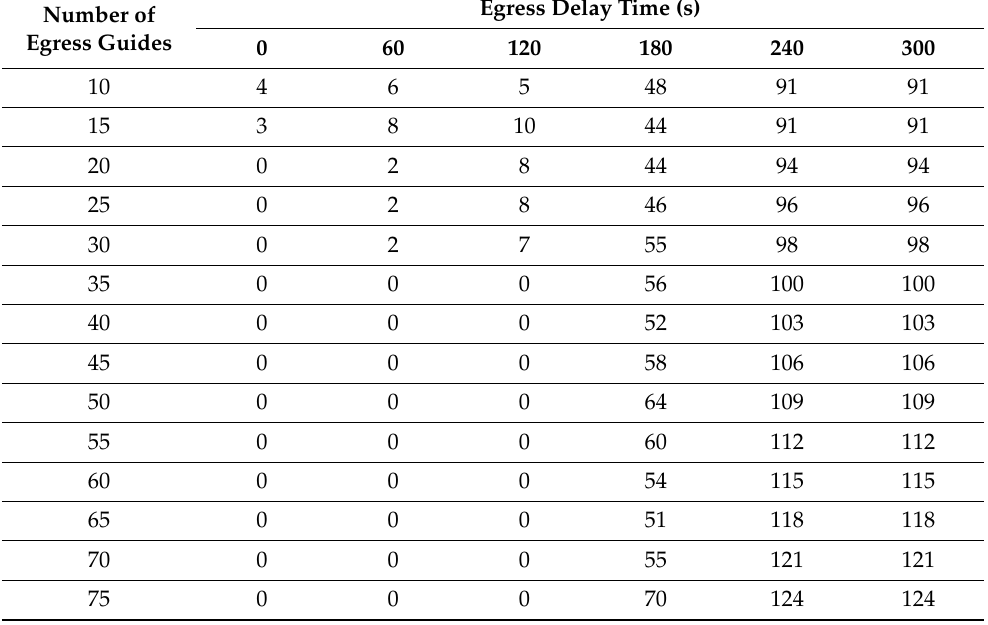
Table 6. Number of casualties for nursing hospital without smoke exhaust